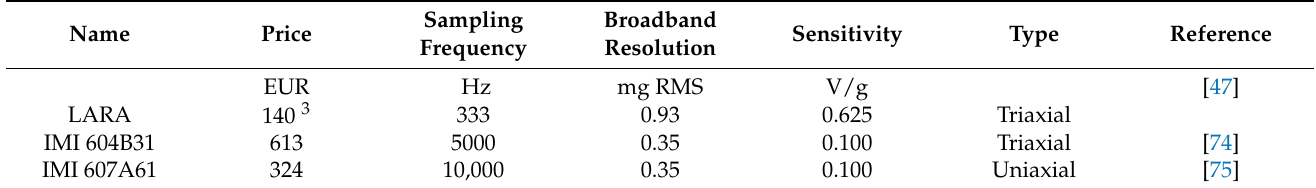
Table 3. Comparing a LARA with standard accelerometers for the SHM of